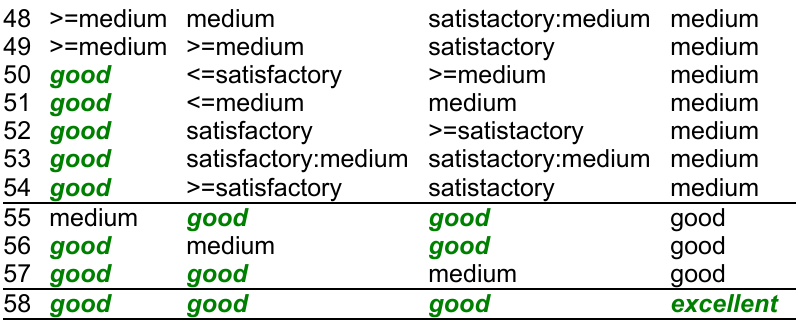
Figure 3. Results of the evaluation of the ICOs Cargox, Tokens, BitClave, Neuromation and WePower